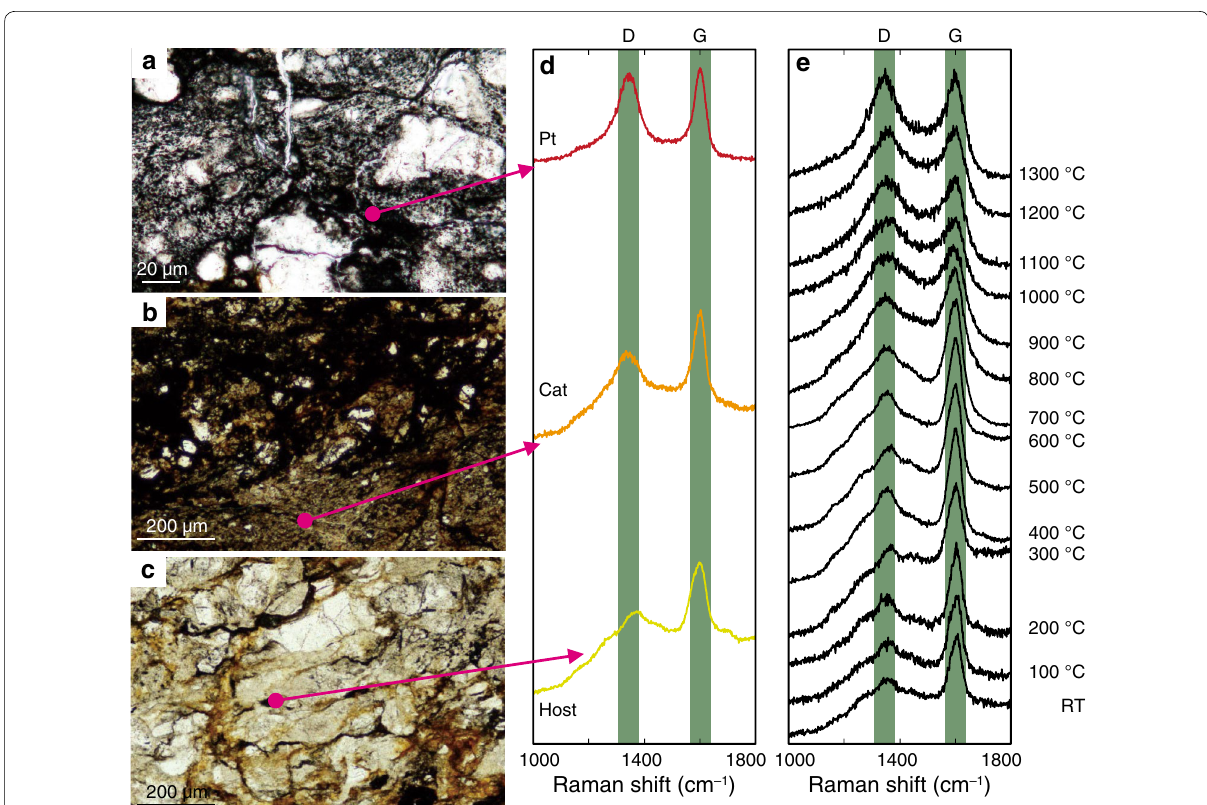
Fig. 5 Locations of CM analytical points (red circles) in the Kure OST (see also Fig. 3b). a Pseudotachylyte, b cataclasite, and c host rock. d Repre- sentative Raman spectra of CM samples. e Raman spectra of experimentally heated CM extracted from host rock. D disordered band, G graphitic